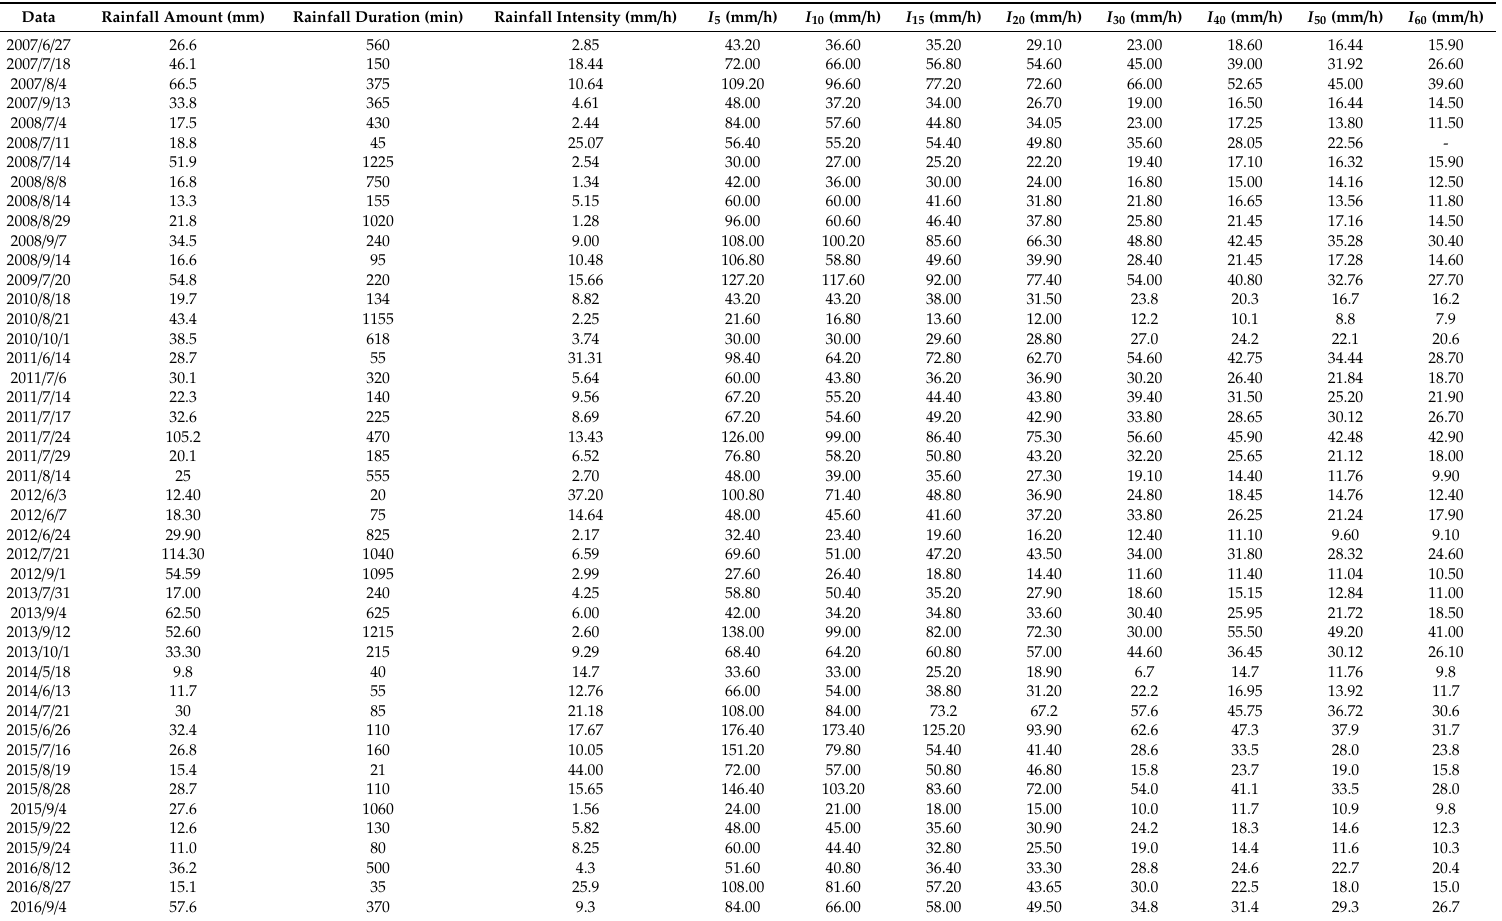
Table A1. The data set of Statistical Rainfall